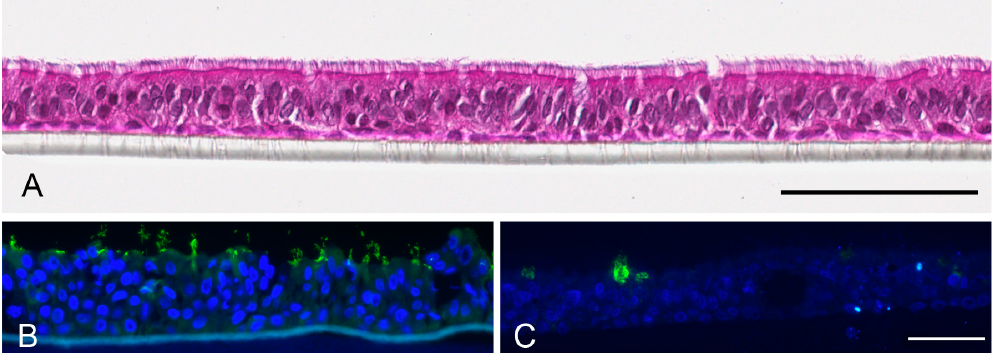
Figure 5. Morphology of MucilAir™ tissues according to hemalaun staining ( A , scale bar: 100 µm) and cellular composition of the tissues according to immunocytochemistry ( B , C ). Anti- α -tubulin staining (green, ( B )) visualized cilia of bronchial epithelial cells and anti-mucin 5AC staining (green, ( C )) visualized goblet cells. Nuclei are counterstained with Hoechst 33342 (blue). Scale bar 50 µm. TEER values of the untreated MucilAir™ cultures significantly decreased over 21 d for cultures from 563 ± 66 Ω × cm 2 at 1 d to 282 ± 24 Ω × cm 2 at 21 d. Therefore, tissues were studied for only 14 d of exposure with LPS and CNT4003. While TEER values of the LPS- treated tissues were significantly decreased compared to 1 d, CNT4003 particles did not affect TEER values over the entire observation time of 14 d (Figure 6).